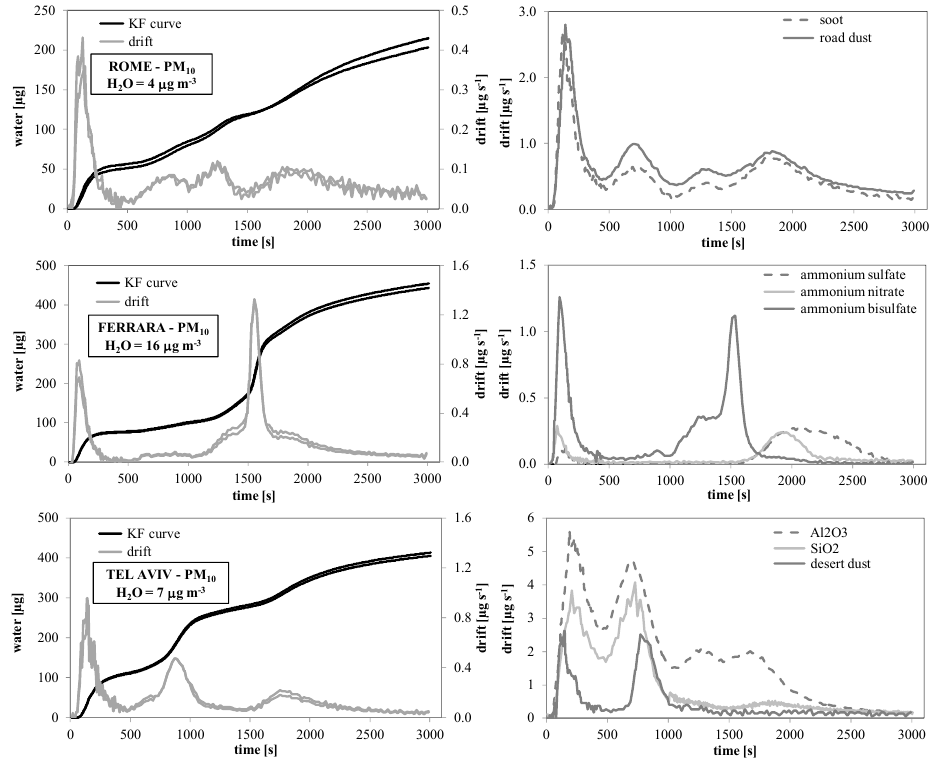
Fig. 6. Examples of the Karl-Fisher curves of PM 10 paired samples collected side-by-side at the three sites (left panels) and drift profiles of some single hydrophilic components of PM (right